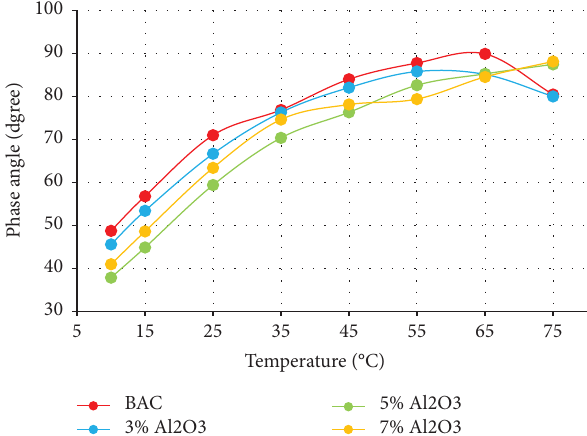
Figure 5: Te isochronal plot for δ of the base and modifed asphalt binders.